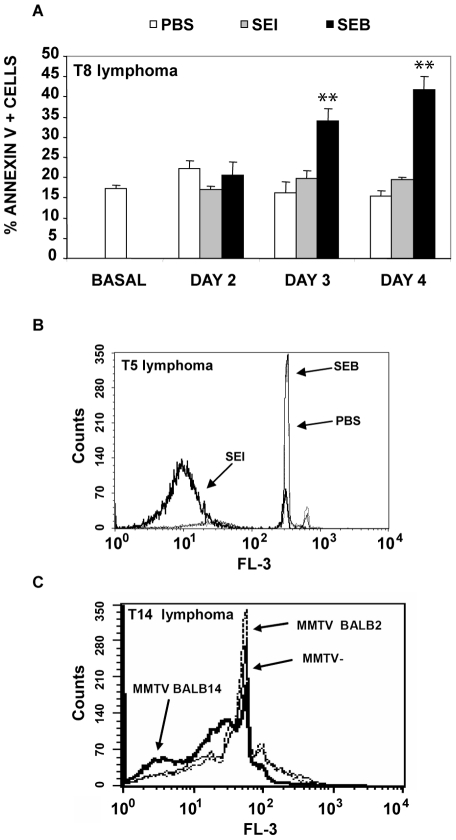
Sags increase apoptosis of cognate lymphoma T cells in vitro.(A and B) T8 or T5 lymphoma cells (2.5×105) were co-cultured with 0.7×105 intraperitoneal macrophages in the presence of 10 µg/ml of the indicated bacterial Sags or PBS. (A) Percentage of apoptosis in T8 cells at different days as assessed by FACS using Annexin V-7AAD. Data are expressed as the mean ± SD, n = 4, ** p<0.01. (B) Representative overlayed histograms of PI showing the DNA content in T5 cells cultured with 10 µg/ml of SEB, SEI or PBS during 3 days. (C) T14 lymphoma cells (2.5×105) were co-cultured with 0.7×105 mytomicin-C pretreated splenocytes from (MMTV-) non-infected AKR/J mice, MMTV BALB2- or MMTV BALB14-infected AKR/J mice. The Figure depicts representative overlayed histograms of PI showing the DNA content in T14 cells at day 3 of culture. All the experiments were performed five times with similar results.